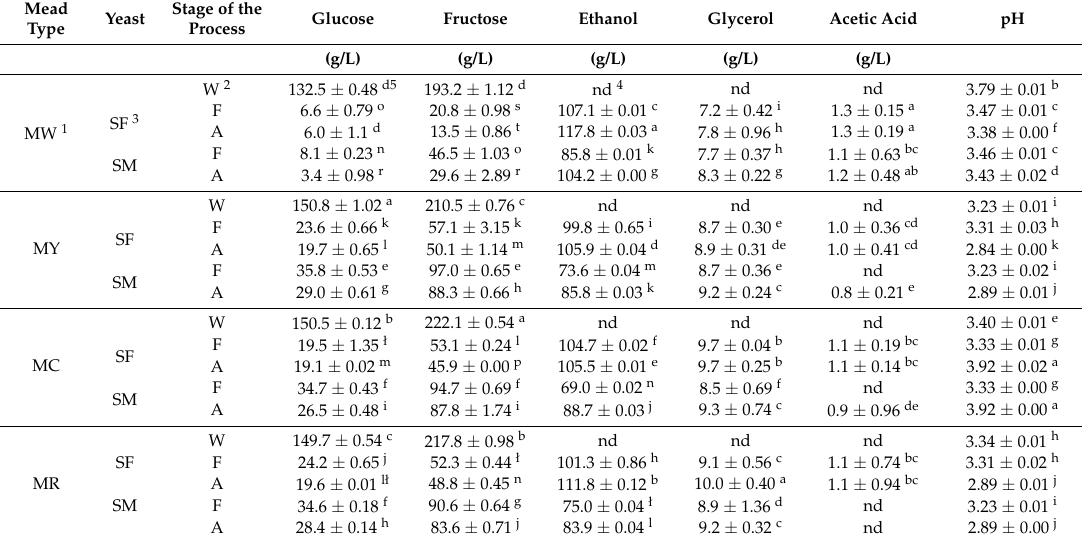
Table 1. Basic physicochemical characteristics and composition of meads with different types of Cornelian cherry juices at particular stages of the manufacture